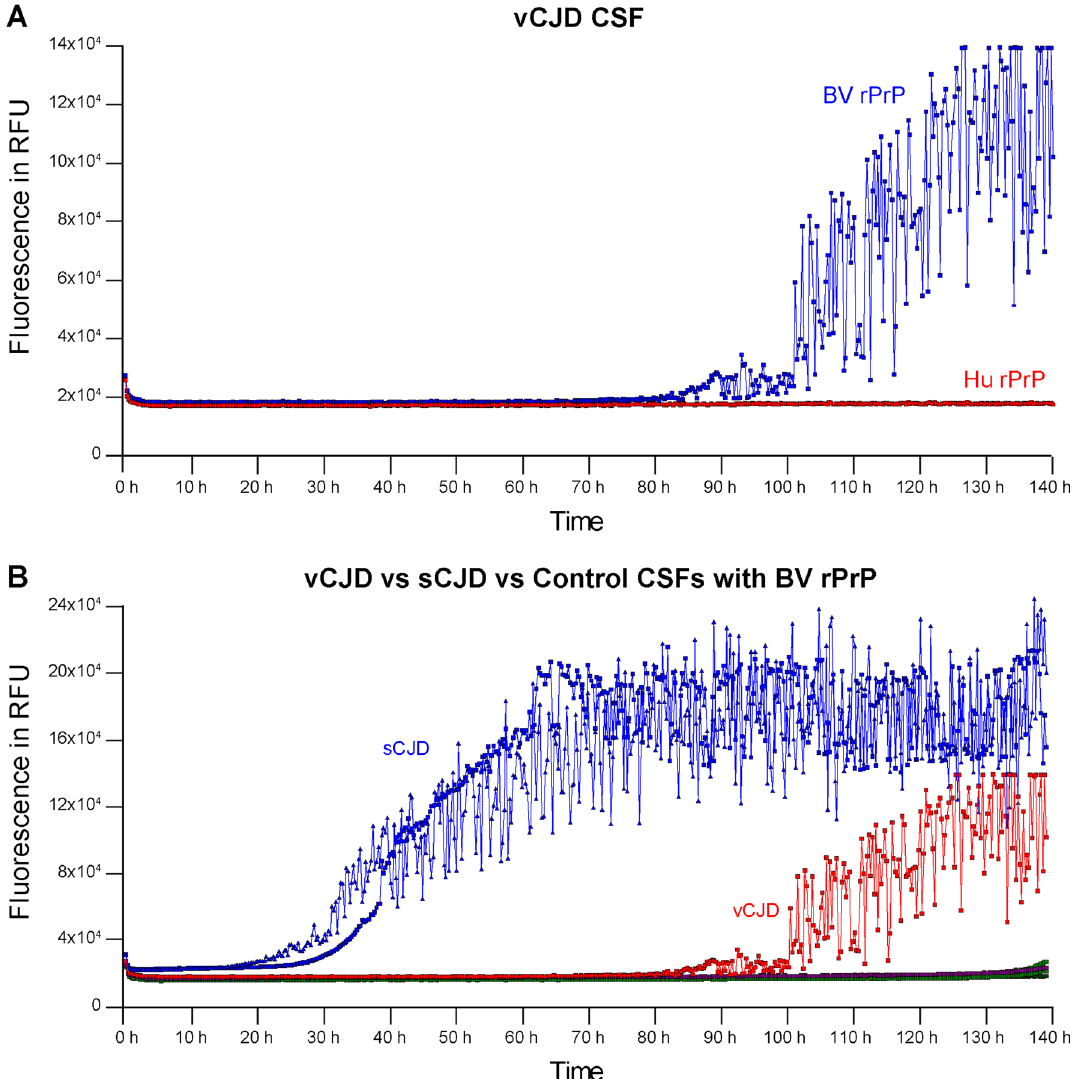
Figure 1. Comparisons between RT-QuIC reactions seeded by CSF samples from sCJD and vCJD cases, using either Hu rPrP or BV rPrP. Each curve is the mean with standard deviation of 4 replicate wells. ( A ) RT-QuIC reactions using BV rPrP (blue) and Hu rPrP (red) in 96-well format at 45 °C, seeded by vCJD CSF; BV rPrP showed a positive result (2/4) but with a long lag phase while Hu rPrP was negative (0/4). ( B ) Comparison of RT-QuIC reactions using BV rPrP, seeded by CSFs from sCJD (blue) and vCJD (red) cases at 45 °C; reactions seeded by sCJD CSFs showed the classic positive curves while that seeded by vCJD CSF replicated the delayed positive curve in ( A